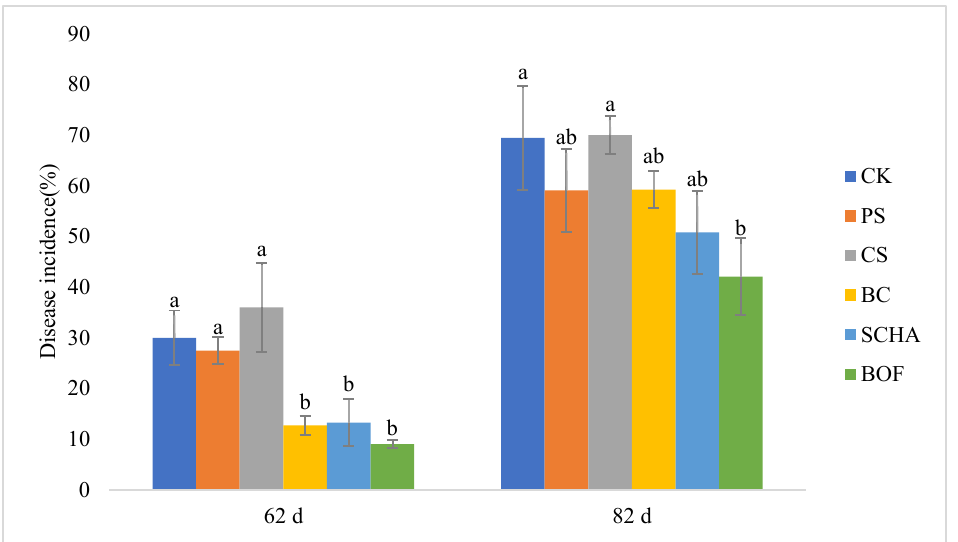
Figure 1. Incidence of tomato bacterial wilt with different treatments on 62 d and 82 d after trans- planting. Different letters represent significant differences among different treatments at the same transplanting. Bars indicate standard error ( n = 4). Amendment treatments include CK (no fertiliza- tion); PS (potassium silicate); CS (calcium silicate); BC (biochar); SCHA (calcium silicate humic acid); BOF (bio-organic fertilizer).